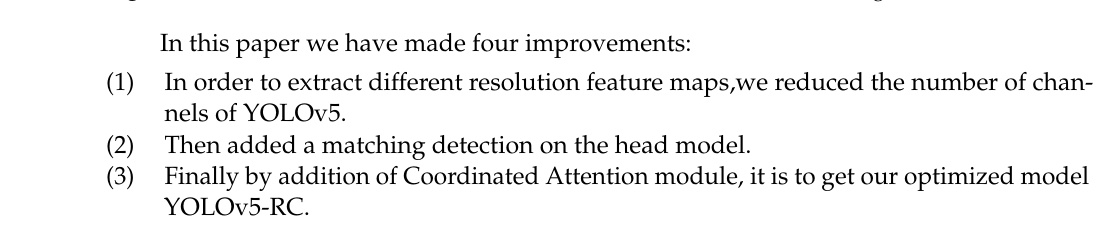
Figure 2. ( a ) YOLOv5, ( b )YOLOv5-RC,the added structure is marked with light color